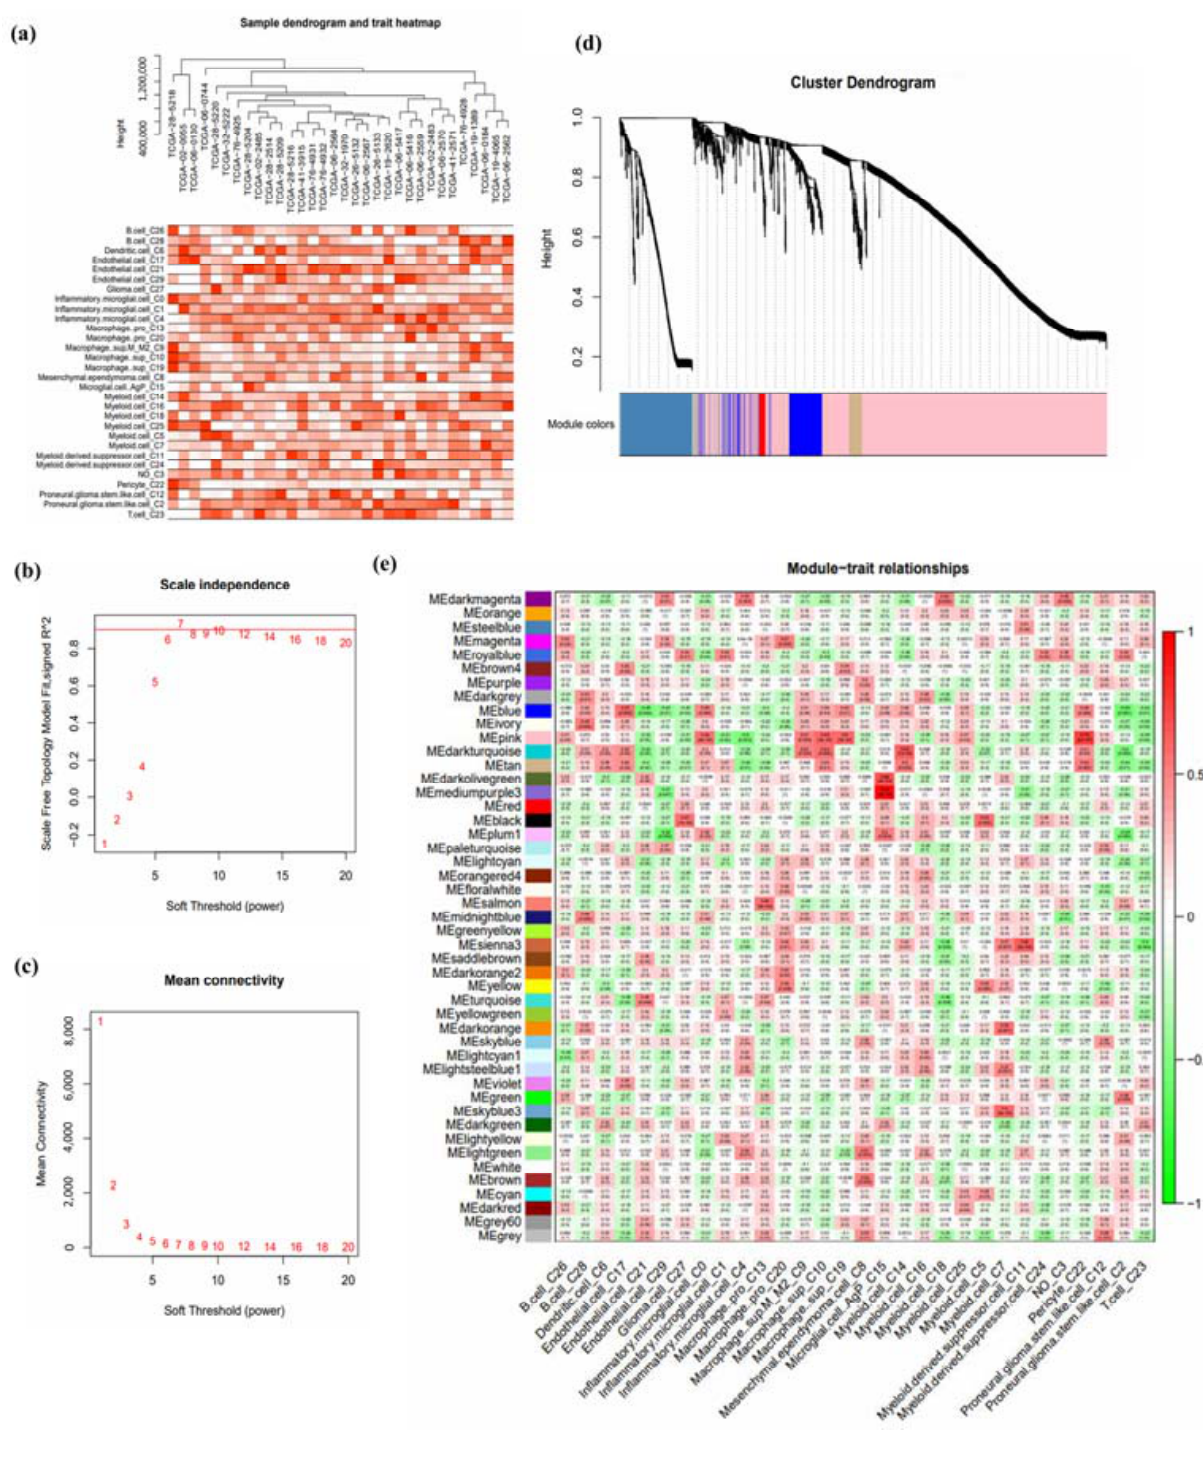
Figure 2. Weighted Gene Co-expression Network Analysis. WGCNA was conducted to investigate the correlation between the fraction of the chosen cell groups and RNA expression from 35 TMZ- treated patients. ( a ) The correlation was demonstrated in the clustering dendrogram. ( b , c ) Power = 7 was chosen as the appropriate soft power value. A total of 47 modules were constructed and visualized as a ( d ) cluster dendrogram and ( e ) correlation